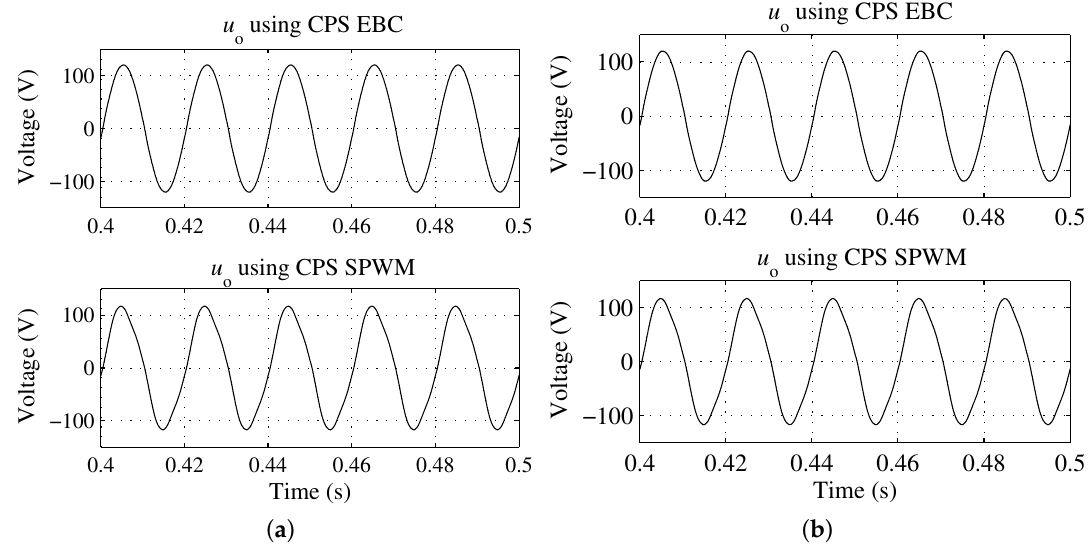
Figure 12. The simulation results of the five-level prototype under the case of unbalance DC voltages and DC voltages with fluctuations. ( a ) DC voltage u 1 contains a ripple with a frequency of 100 Hz and an amplitude of 16 V; and ( b ) DC voltage of each cascaded unit contains a frequency of 100 Hz and an amplitude of 8 V.